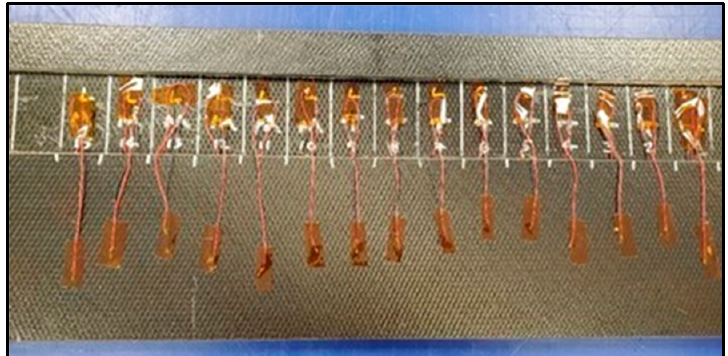
Figure 8. Bonded coupons after adhesive cure.